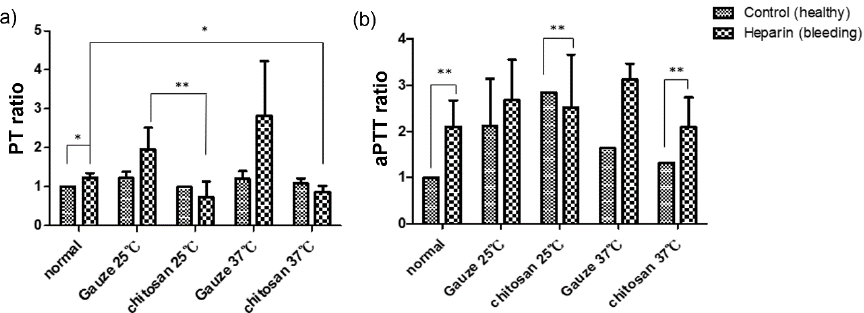
Figure 3. Effects of chitosan and regular gauze dressings on ( a ) prothrombin time (PT) and ( b ) acti- vated partial thromboplastin time (aPTT) (* p < 0.05, ** p < 0.01).